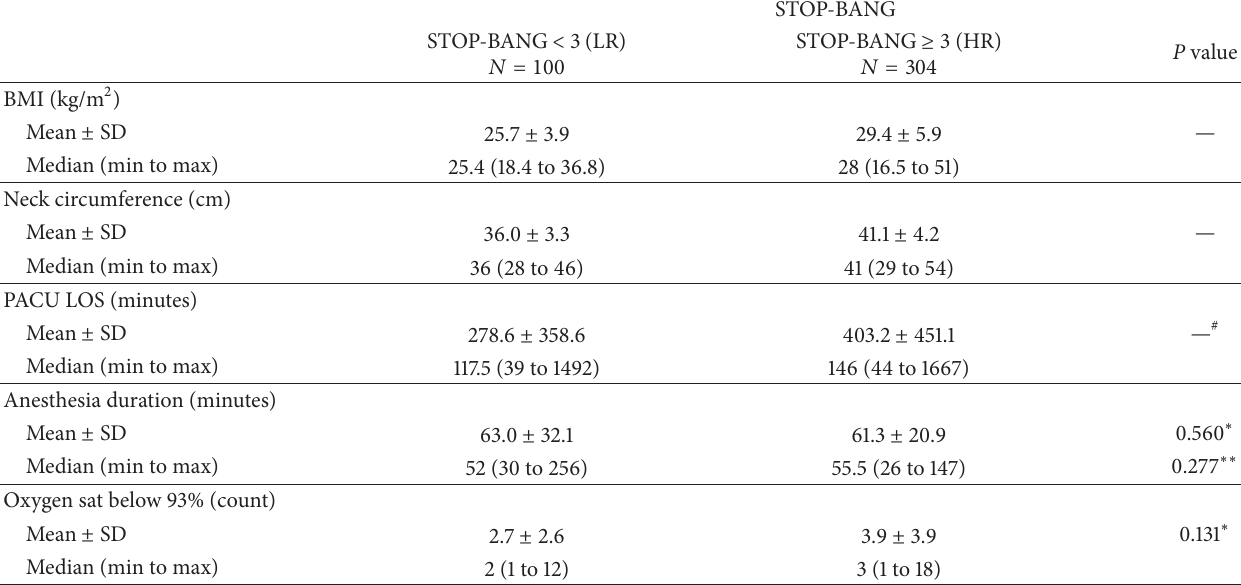
Table 2: Patient characteristics based on STOP-BANG questionnaire.